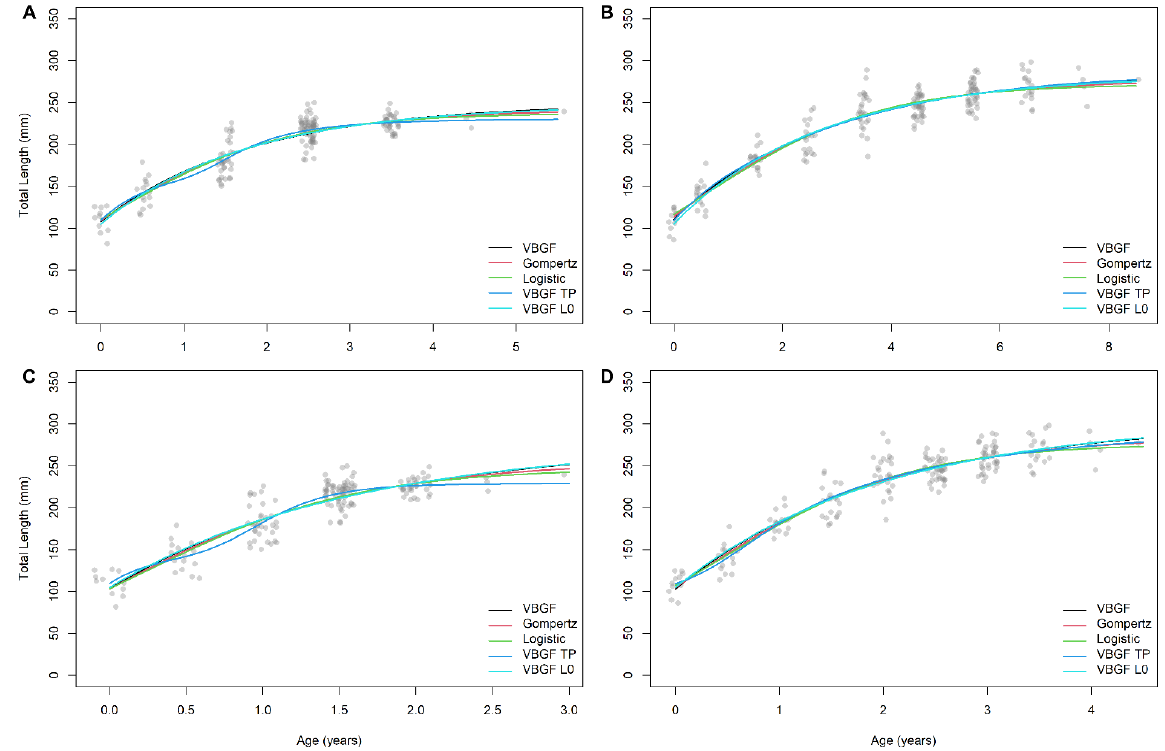
Figure 4. Growth curves estimated for Urotrygon microphthalmum from northeastern Brazil. ( A ) male, one ring per year; ( B ) female, one ring per year; ( C ) male, two rings per year; ( D ) female, two rings per year. Gray circles are observed age.